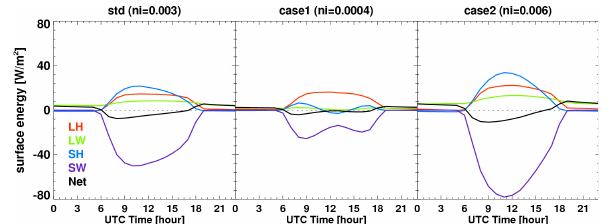
Figure 8 Dust impact on the diurnal cycle of surface energy budget averaged over the 6 Fig. 8. Dust impact on the diurnal cycle of surface energy bud- WAM region (6 o N-17 o N and 15 o W-10 o E) from WRF-Chem in three cases with different 7 get averaged over the WAM region (6 ◦ N–17 ◦ N and 15 ◦ W–10 ◦ E) from WRF-Chem in three cases with different dust absorption dust absorption properties.‘ni’ represents the imaginary part of the refractive index of 8 properties.“ n i ” represents the imaginary part of the refractive index dust. ‘LH’ is latent heat; ‘LW’ is LW radiation; ‘SH’ is sensible heat; ‘SW’ is SW 9 of dust. ‘LH’ is latent heat; “LW” is LW radiation; “SH” is sensible radiation; and ‘Net’ is the sum of the total energy fluxes (i.e., LH+LW+SH+SW). 10 heat; “SW” is SW radiation; and “Net” is the sum of the total en- ergy fluxes (i.e., LH+LW+SH+SW). Positive refers to more energy Positive refers to more energy fluxes into the surface or less energy fluxes out of the 11 fluxes into the surface or less energy fluxes out of the surface. 12